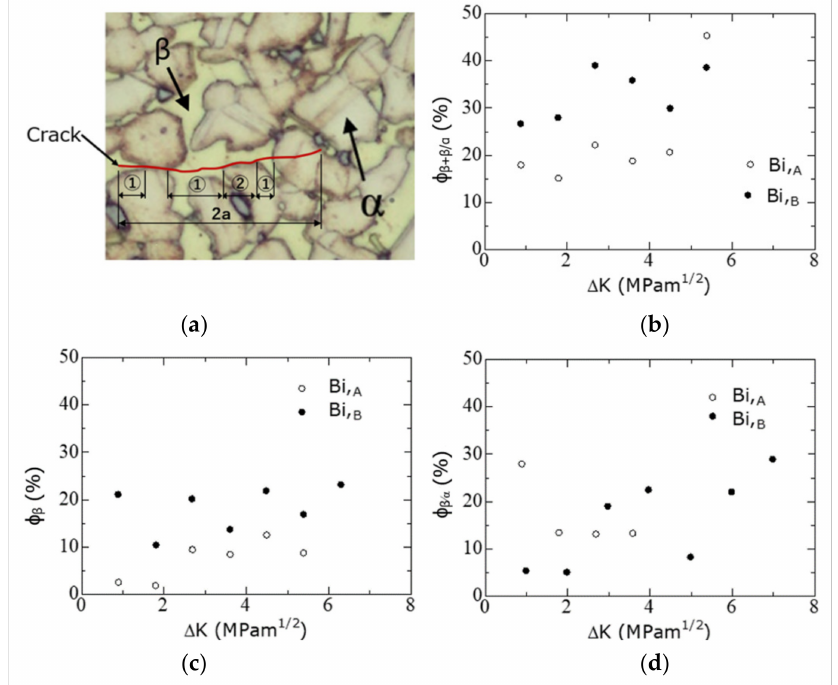
Figure 11. Involvement of β phase in the FCG path: ( a ) illustration of FCG path; ( b ) φ β + β / α ; ( c ) φ β ; and ( d ) φ β / α